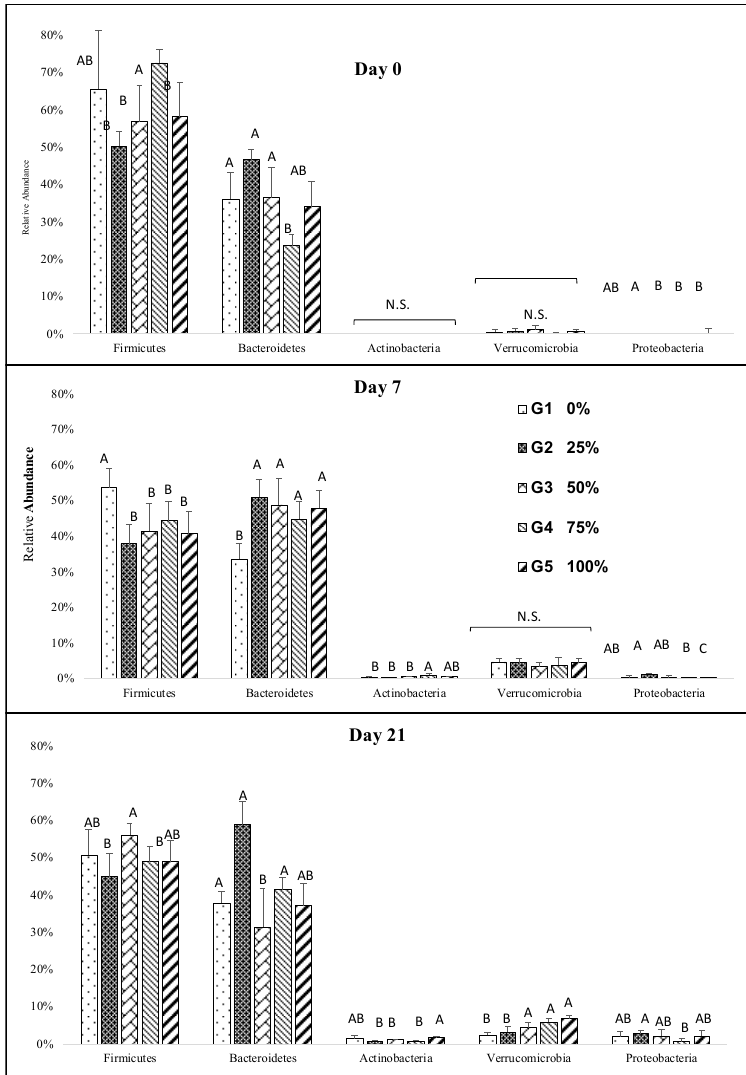
Figure 2. Impact of increasing dietary melanoidin malts on the composition of the gut microbiota at the phylum level during the study. Significant differences ( p < 0.005) are indicated by different letters ( n = 5).